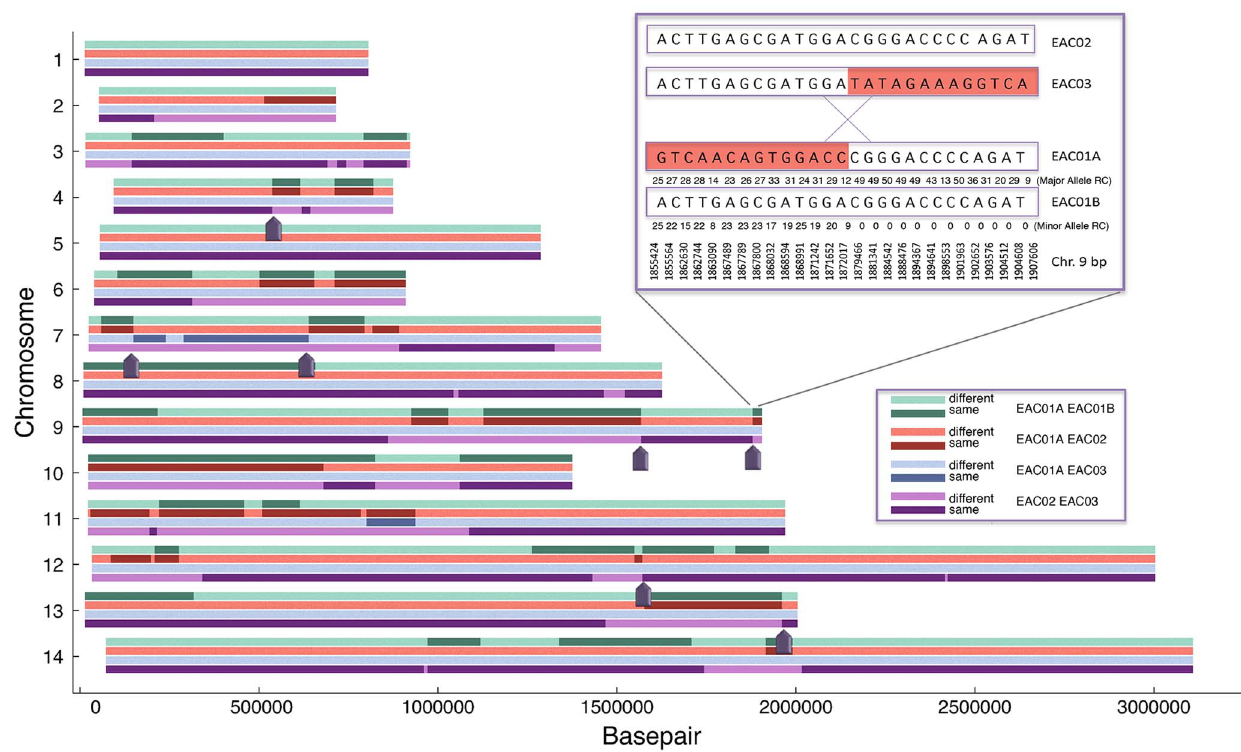
Figure 4. Multiple two-way comparisons show evidence of reciprocal recombination events. To ensure that only high quality positions would be used, the 55,399 genotyped loci were stringently filtered. The filtering criteria was that there had to be more than 20 read counts for the major allele of each comparison (EAC01, EAC02, and EAC03), and that all three strains’ SNV positions differed from the reference. A likelihood function was generated examining 10,000 basepair windows for recombination and assumed that each transition (same to different in each pairwise comparison taken individually) could be considered a chance of recombination. A smoothing kernel was applied to differentiate if a position was likely to be the same by chance or due to recombination and depended on the distance of identical neighboring SNVs (the further